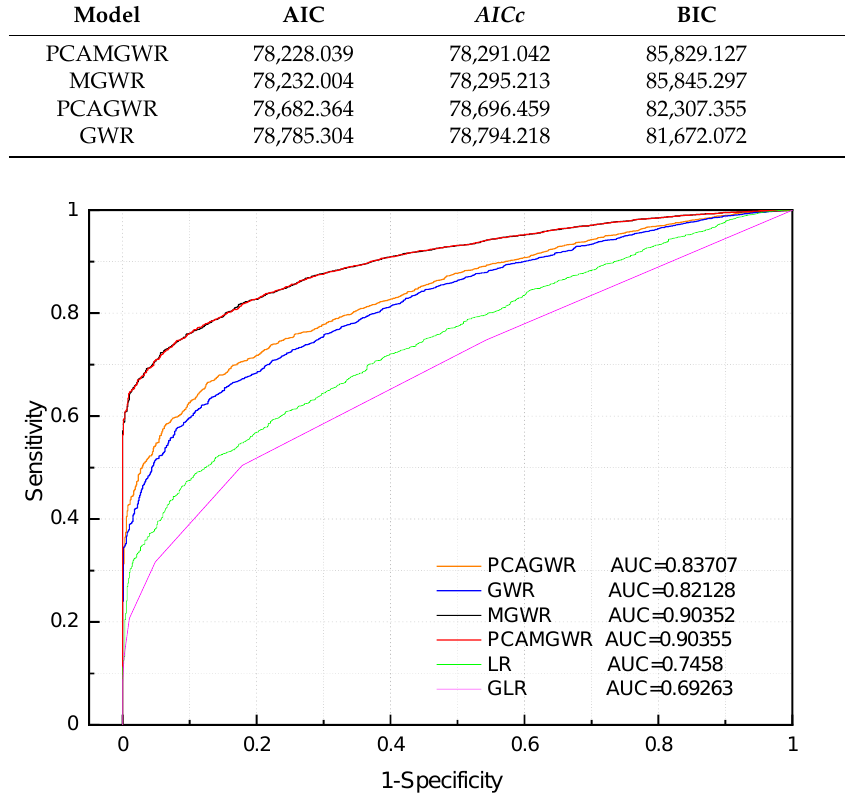
Figure 13. Area under the ROC for different models. Figure 14a shows the convergence of SOC-f during the fitting of the back-fitting algorithm for the MGWR model and PCAMGWR model. The speedy convergence rate means that bandwidth was not chosen at each iteration step, and the optimization stopped at convergence inversely. It can be seen from Figure 14b that the optimal bandwidth was selected based on AICc at a slow convergence, and the AICc value did not continue to decline. It is hard to differentiate the SOC-f of PCAMGWR and MGWR models in detail, and the PCAGWR model represented by the black dot plot was better than the GWR model regarding the convergence of AICc